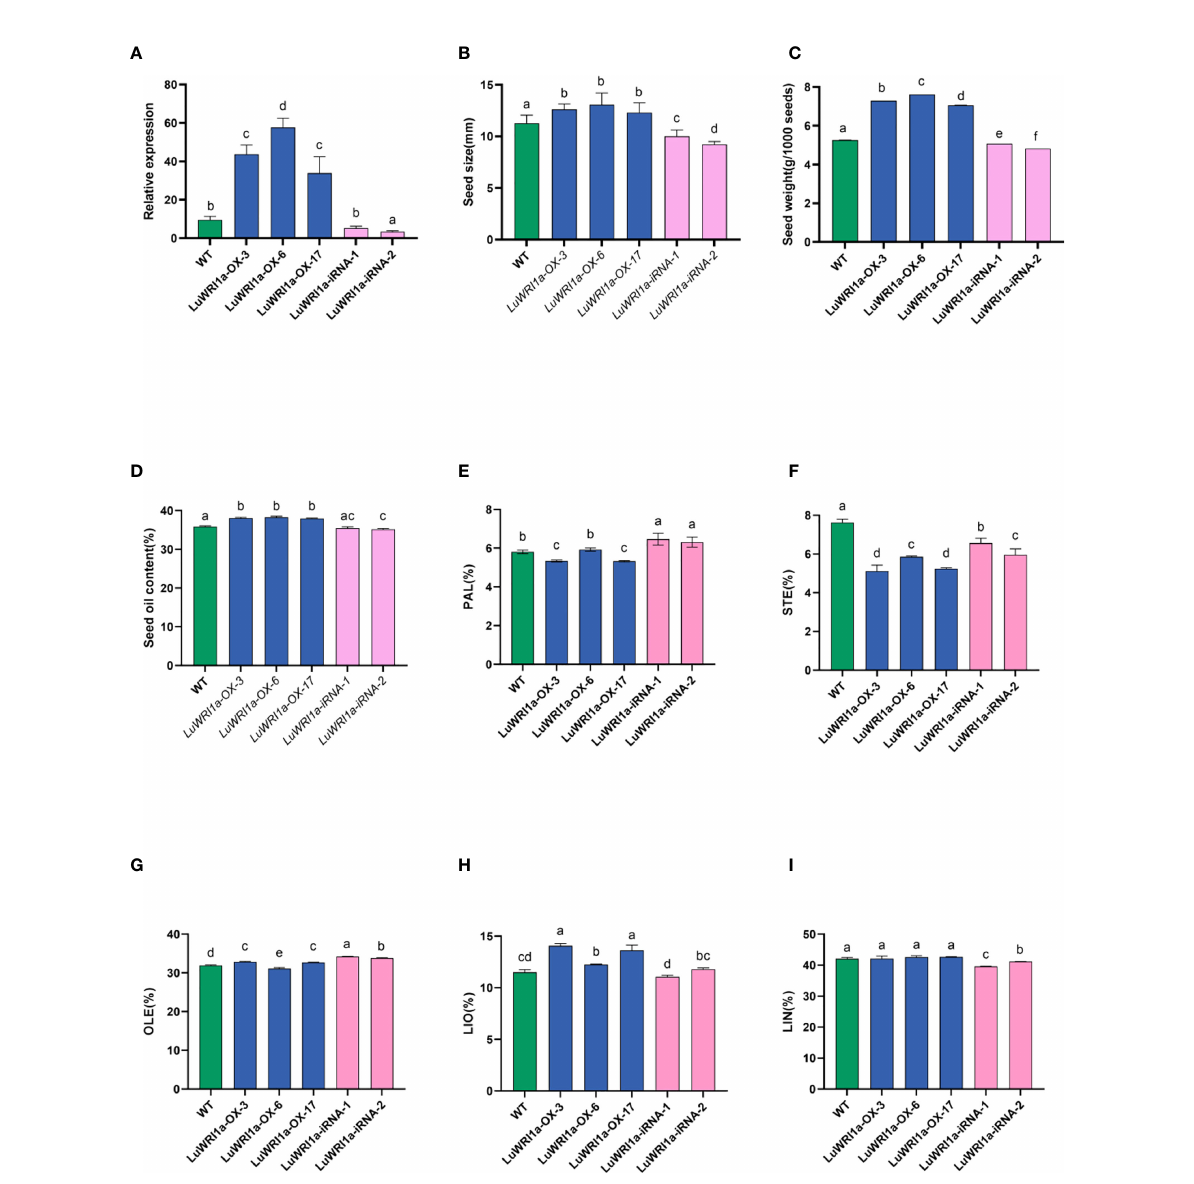
FIGURE 5 Effects of overexpression of LuWRI1a on seed weight, seed size, and seed oil content of fl ax. (A) LuWRI1a expression transcript was assayed in mature seeds from transgenic fl ax, normalized by that of actin. (B) Comparison of the sizes of non-transgenic and genetically modi fi ed fl ax seeds. Error bars represent SE (n = 10). (C) 1,000-seed weight of untransformed fl ax seeds and fi ve transgenic lines. Error bars represent SE (n = 3). (D) Oil contents of untransformed fl ax seeds (WT), three independent T3 pEarlyGate101::LuWRI1a transgenic lines ( LuWRI1a-OX-X ), and two independent T3 pBIB-BASTA-35S-GWRNAi::LuWRI1a ( LuWRI1a-iRNA-X ). The oil contents were determined by the Soxhlet method. DW, dry weight. Error bars represent SE (n = 3). (E – I) Fatty acid composition from seeds of (WT) and transgenic plants were examined by GC assays. Error bars denote SE (n =